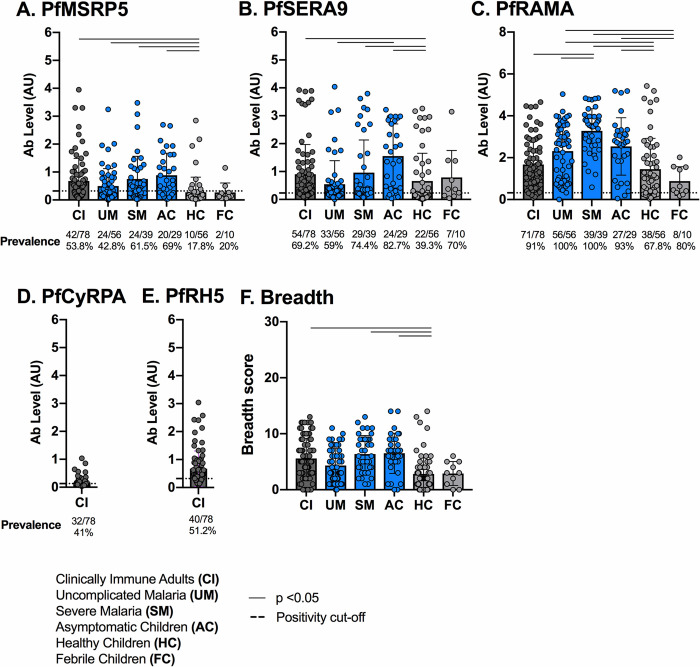
Prevalence and levels of IgG to P. falciparum merozoite antigens per clinical group.Levels (AU, mean with SD) of IgG specific for PfMSRP5 (A.), PfSERA9 (B.), PfRAMA (C.), PfCyRPA (D.) and PfRH5 (E.) were measured in clinically immune adults (CI, dark grey), children with P. falciparum malaria (asymptomatic children (AC), uncomplicated malaria (UM), severe malaria (SM), blue) and children without P. falciparum malaria (healthy children (HC), febrile children (FC), light grey). A Kruskal-Wallace test and Dunn’s post-hoc test were performed between all possible combinations of two clinical groups. Combinations with statistical significance only (p < 0.05) are represented by horizontal black lines. All p values regardless of statistical significance are shown in S1 Table in S1 File. Positivity cut-offs are represented by a dashed black line. For each clinical group, the number of positive individuals, total number of individuals tested and percent reactivity is shown at the bottom of each panel.